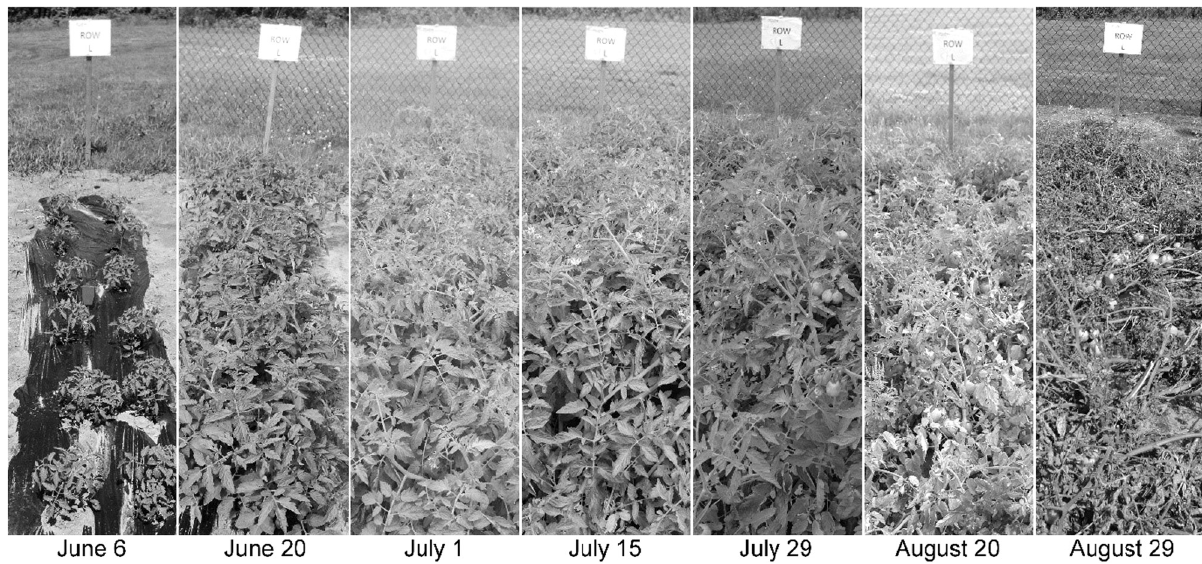
Figure 2: Photographs of a representative plot in which tomatoes were grown on black mulch ( Figure 1a ) taken in June, July and August. Seeds and seedlings were planted on May